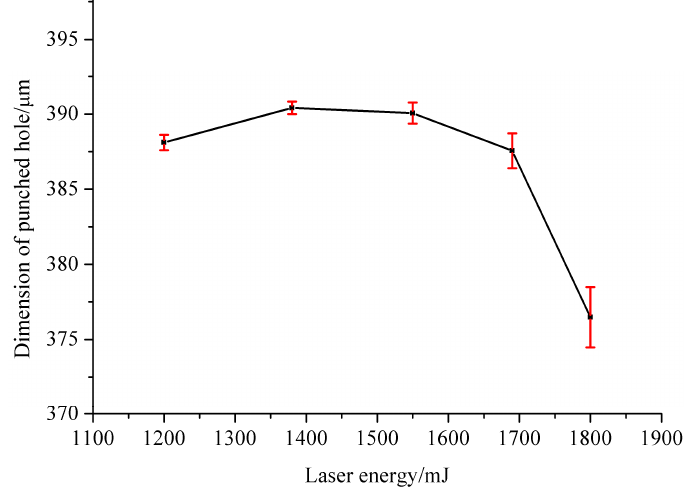
Figure 7. The relationship between laser energy and the dimension of the punched hole.